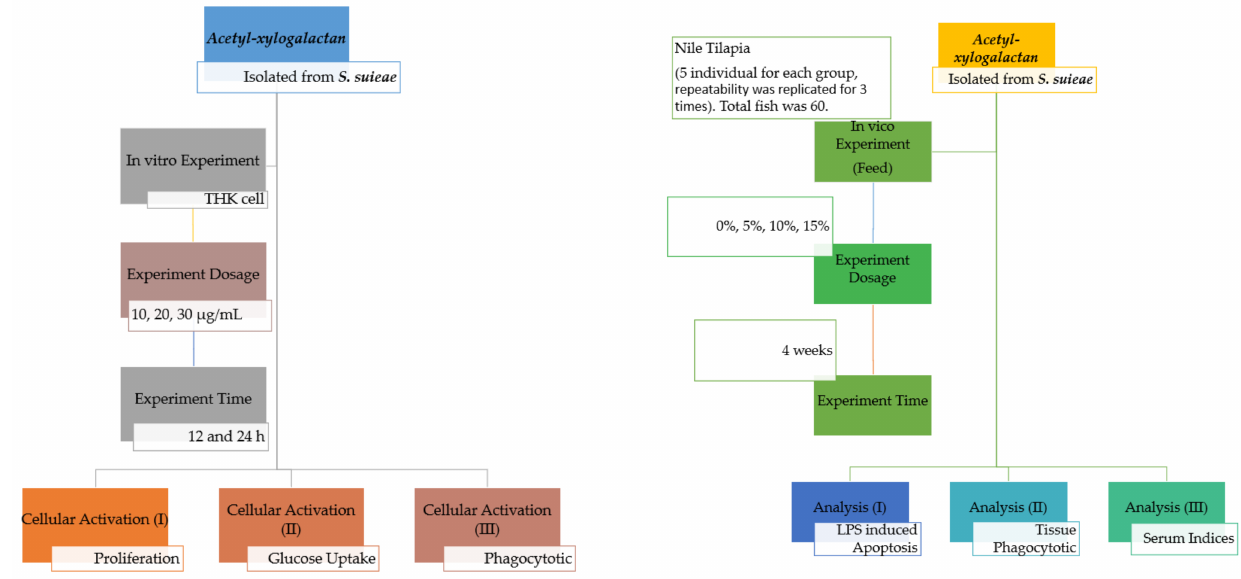
Figure 6. Experimental design graph. ( A ) In vitro design; ( B ) in vivo experiment